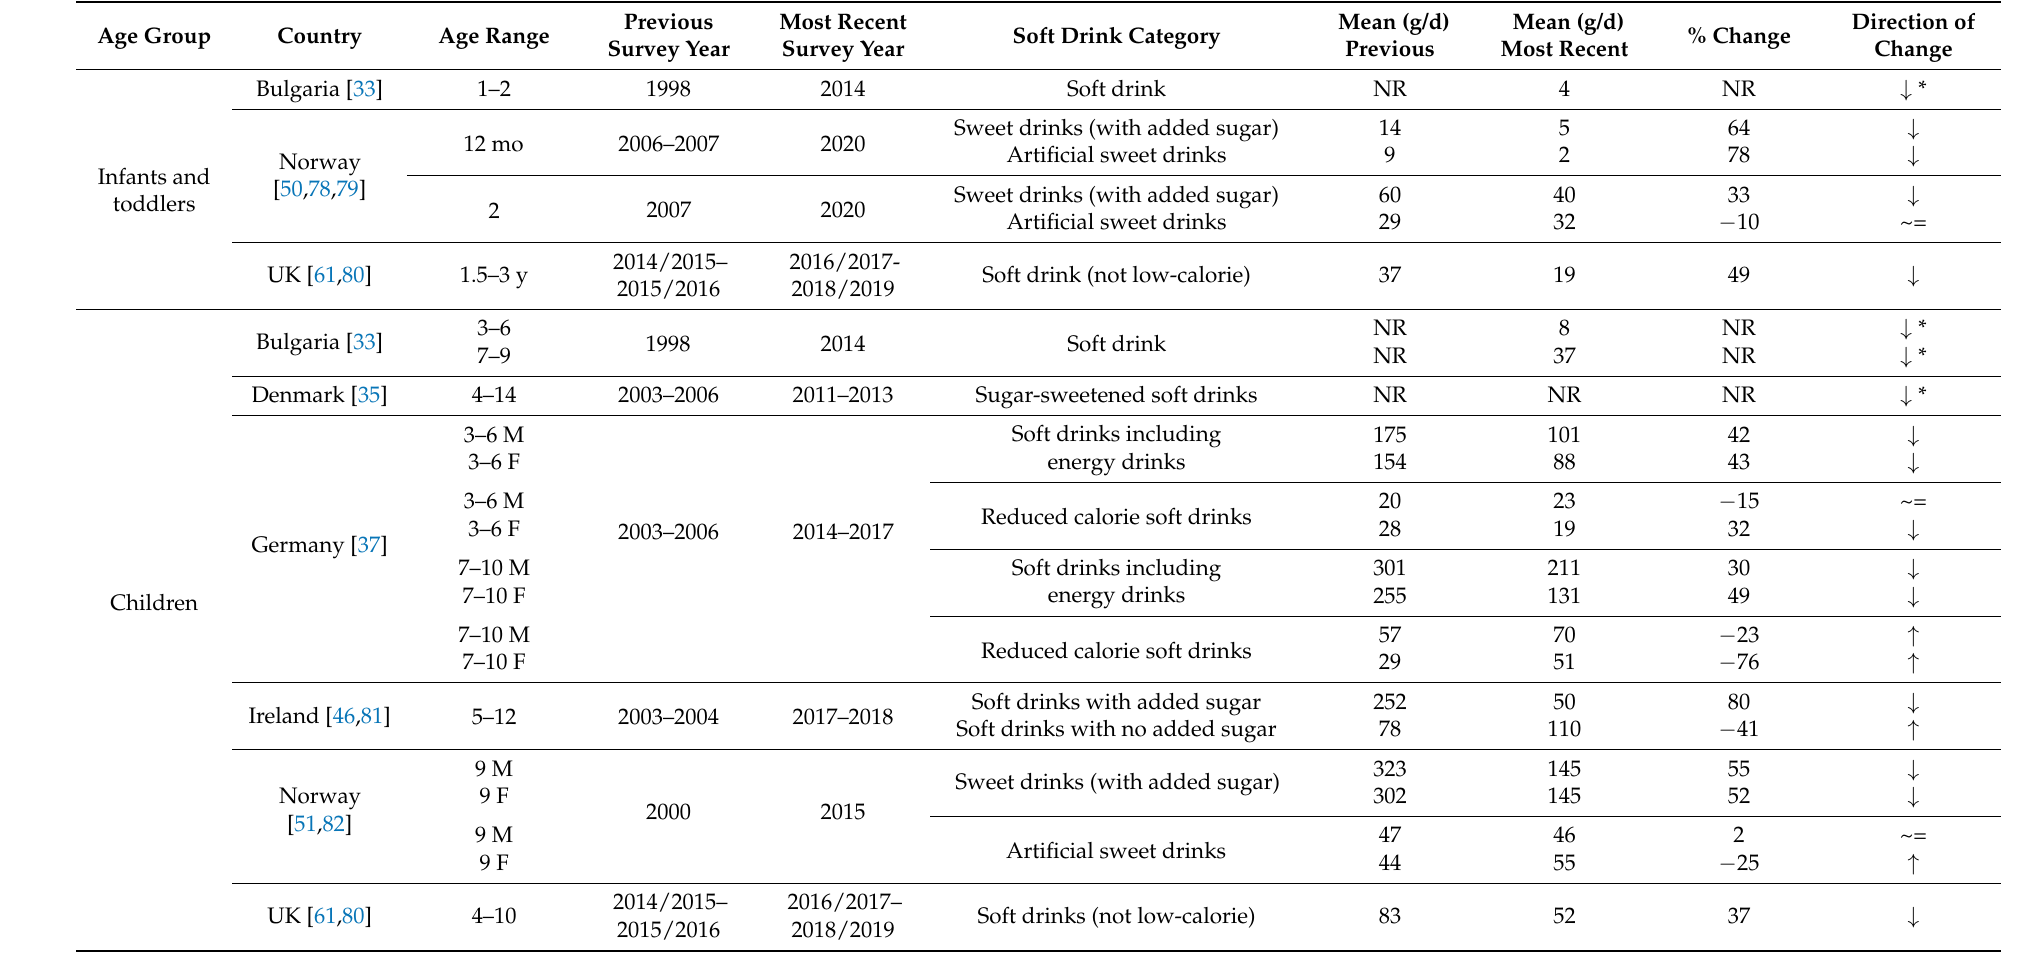
Table 7. Change in soft drink intake over time in the WHO European Region as reported in National Dietary